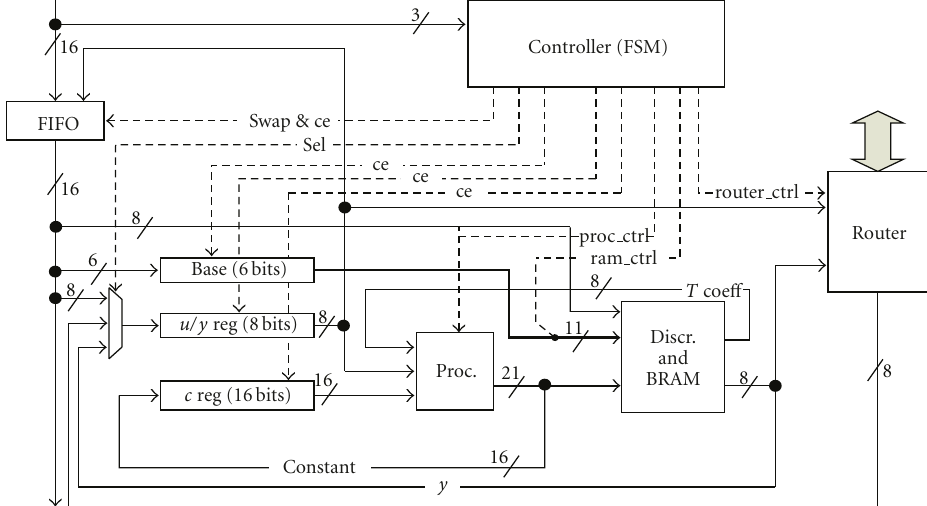
Figure 15: Schematic view of a serial CNN node.